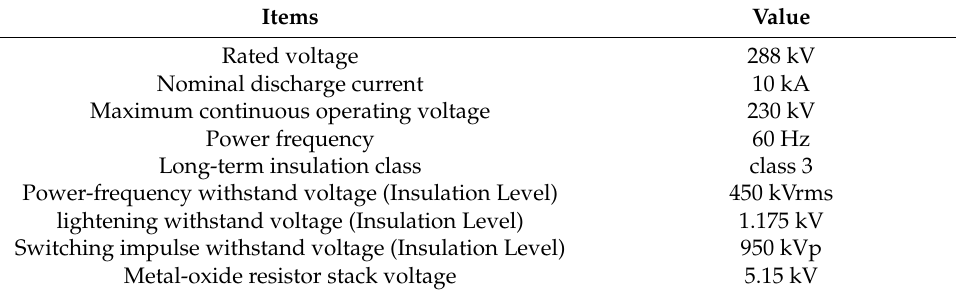
Table 3. Specification of metal-oxide varistor surge arrester. Items Value